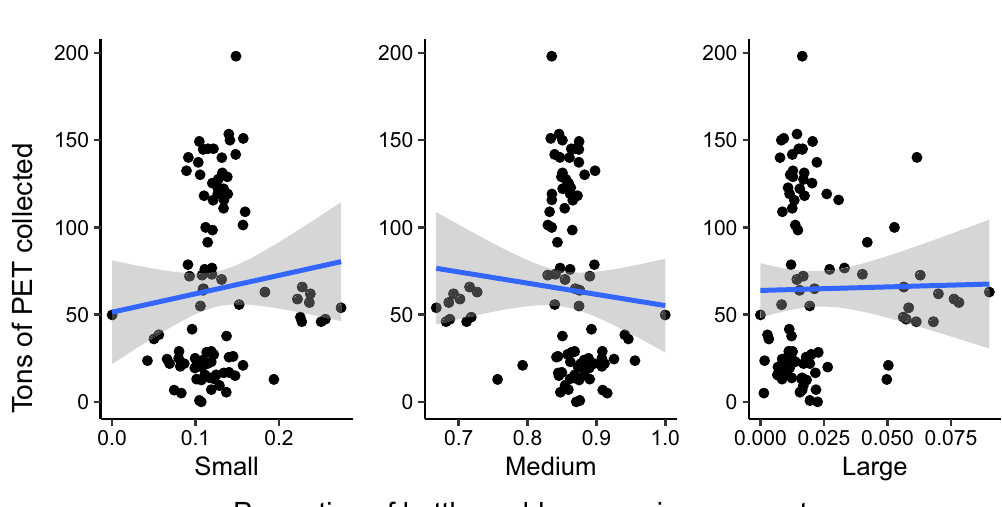
Figure 3. Relationships between PET collected for recycling and proportions of small, medium, and large bottles sold ( n = 96). The blue line represents the best linear approximation and the gray envelope its standard